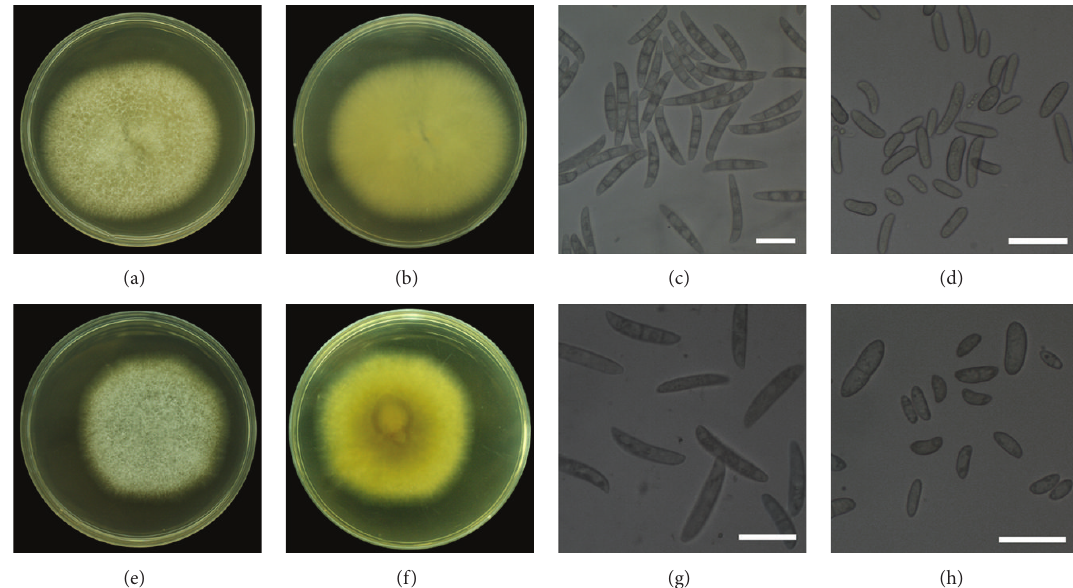
Figure 4: Morphology of F. solani isolate CFD-1 (a–d) and F. oxysporum isolate CFD-1 (e–h). (a, e): front culture character, (b, f): back culture character, (c, g): macroconidia, and (d, h): microconidia. Bars: 50 𝜇 m.